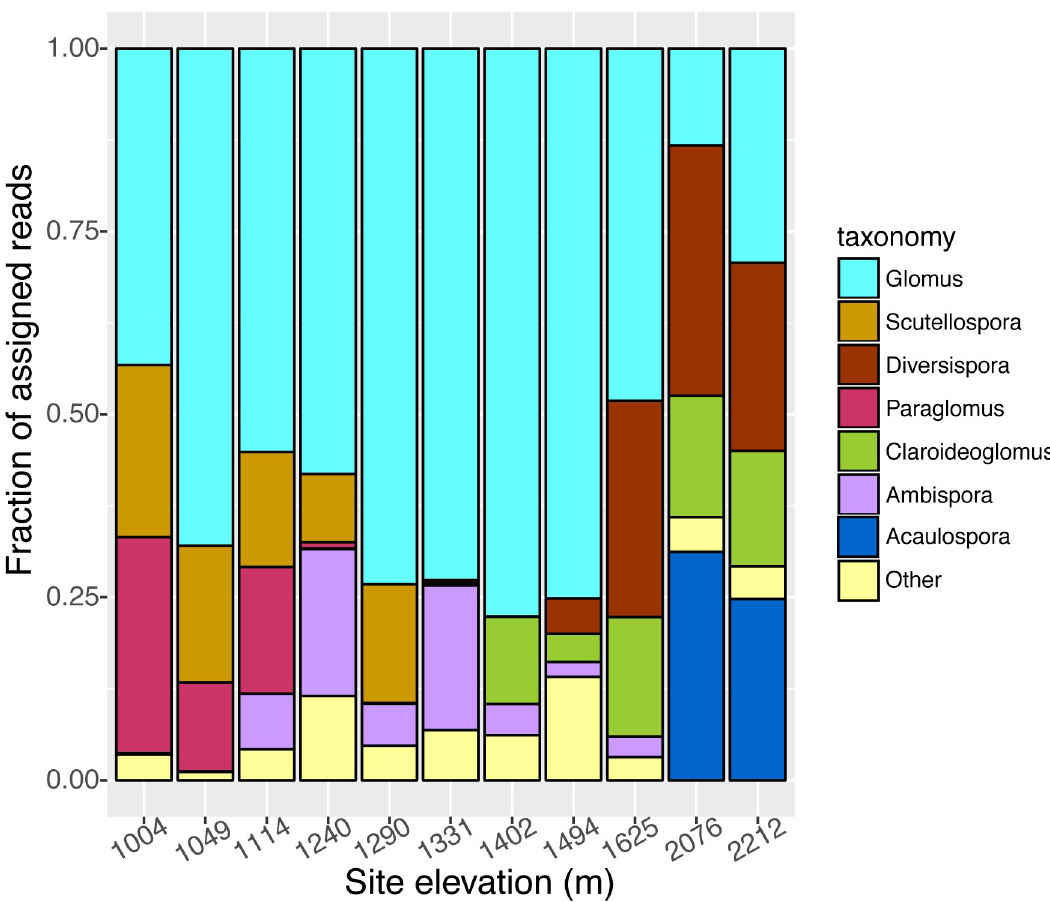
Fig 4. Relative abundances of genera of AMF taxa colonizing Joshua tree roots harvested across an elevation gradient in Joshua Tree National Park. Abundance is estimated as the proportion of assigned sequence reads within each site.